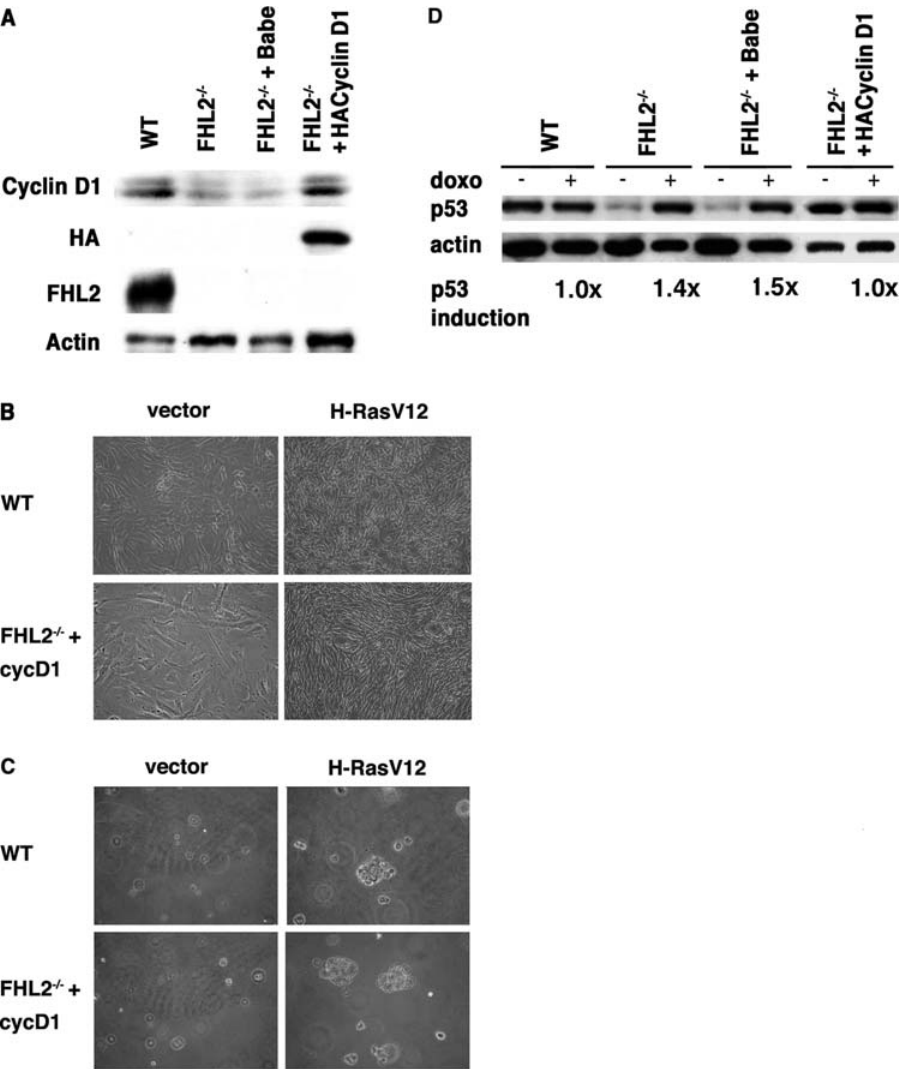
Figure 6. Immortalized FHL2 2 / 2 MEFs stably expressing cyclin D1 are susceptible to transformation by oncogenic Ras. (A) Increased cyclin D1 expression in immortalized FHL2 2 / 2 MEFs after introduction of cyclin D1-HA transgene was confirmed by immunoblotting with anti-cyclin D1 and anti-HA antibodies. (B) Representative phase contrast images of immortalized wt and cyclin D1-HA/FHL2 2 / 2 cell lines transduced with H- RasV12 or empty vector. (C) Soft agar assay. Cells were initially seeded at 5 6 10 4 cells/plate and cultured for 10 days. Images are representative of three wt and two cyclin D1-HA/FHL2 2 / 2 cell lines transduced with H-RasV12. (D) Western blot analysis of p53 induction by doxorubicin in the indicated cell lines as described in Fig.